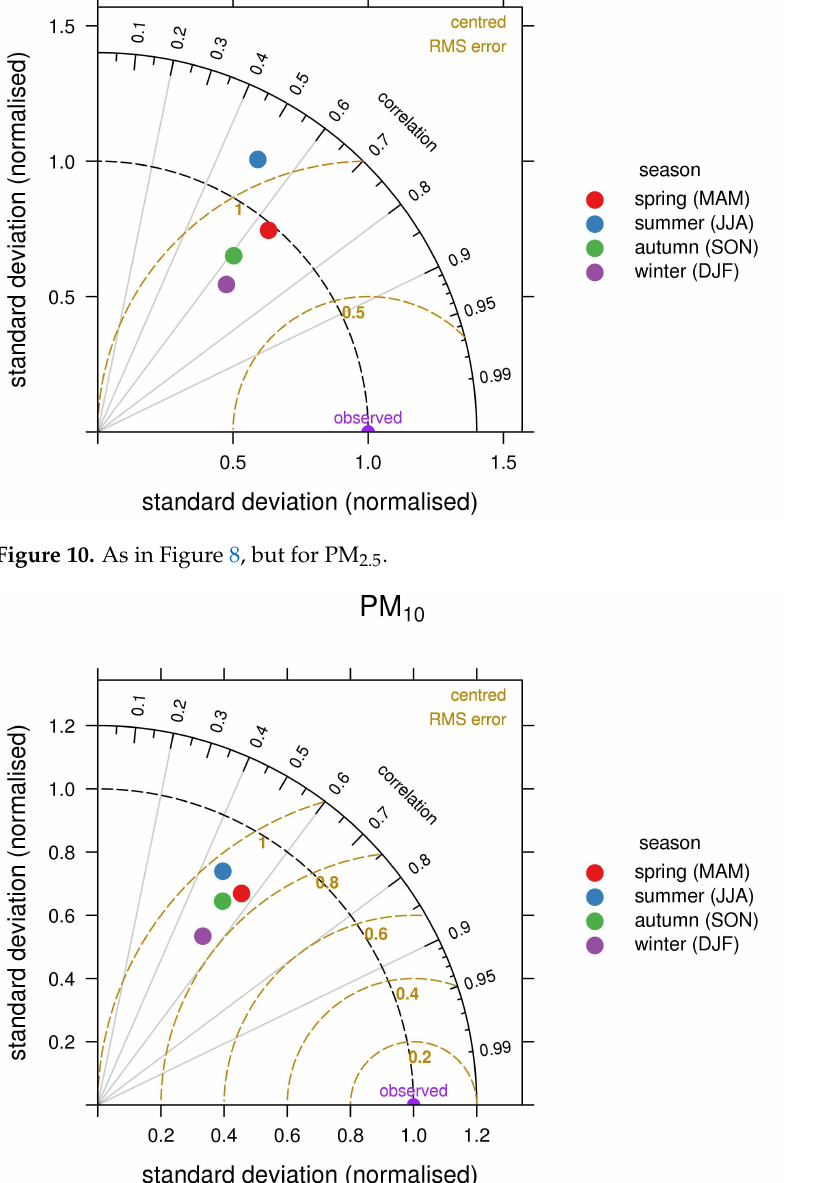
Figure 11. As in Figure 8, but for PM 10